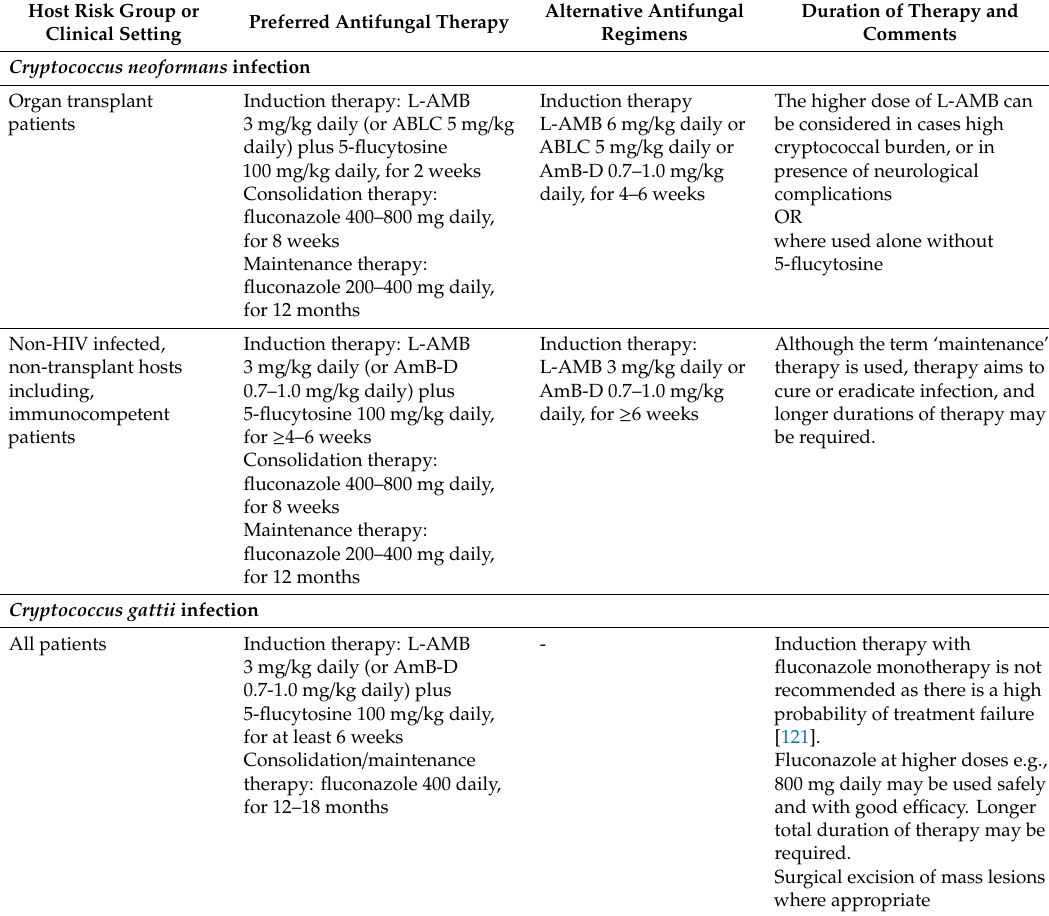
Table 3. General recommendations for the antifungal treatment of central nervous system cryptococcosis due to Cryptococcus neoformans and Cryptococcus gattii in patients without human immunodeficiency virus infection (adapted from Perfect et al. [90] and Chen et al.